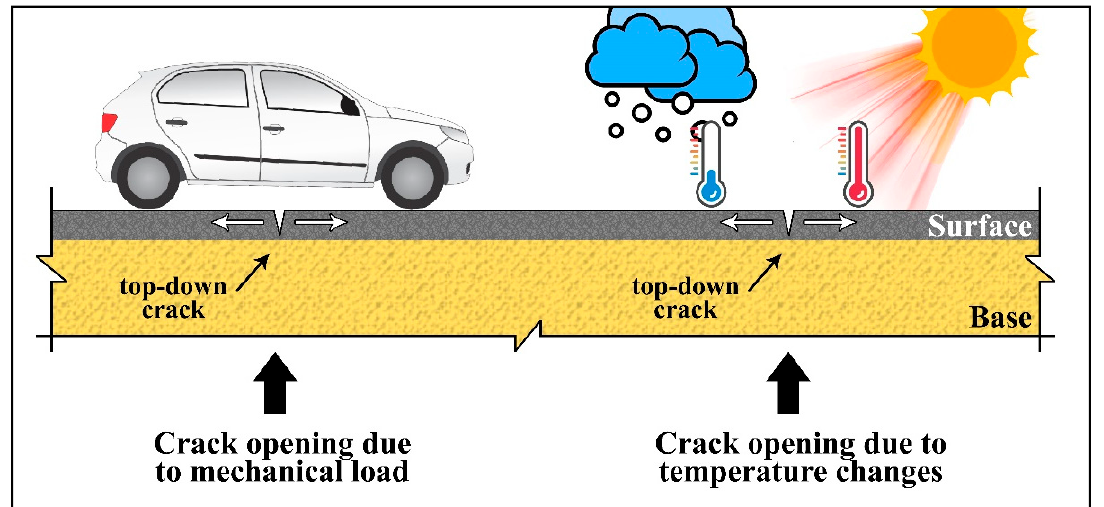
Figure 1. Pure mode I tensile cracking of the pavement induced by traffic and thermal loads.